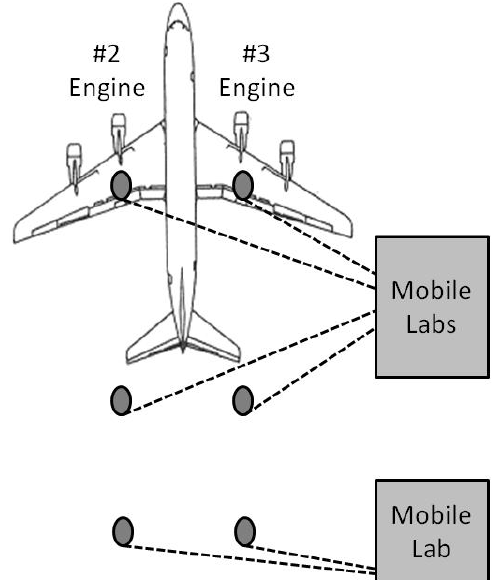
Fig. 1. Diagram of the AAFEX test setup. Exhaust samples were drawn from 1, 30, and 145m probes (circles; details in Anderson et al., 2011) mounted behind both the #2 engine (left, inboard), which burned only JP-8 fuel, and the #3 engine (right, inboard), which burned JP-8 and alternative fuels. Five mobile labs contained instrumentation for the 1m and 30m probes, while a separate lab contained instrumentation specifically for the 145m probe. Probe distances are not drawn to